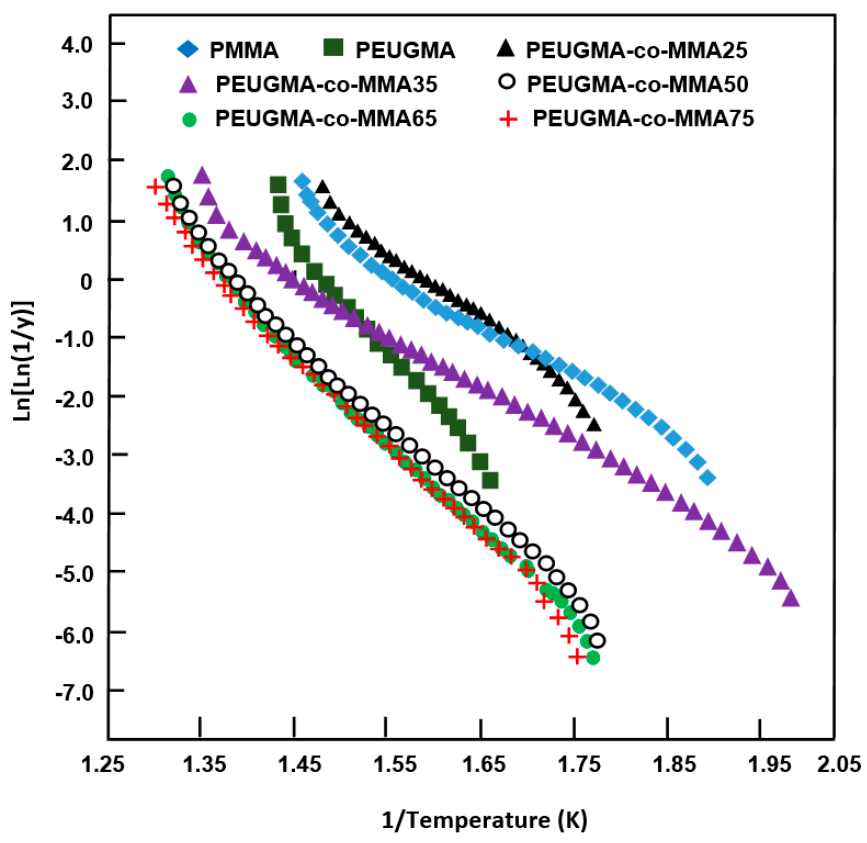
Figure 16. Variation of Ln[Ln(1 / Y)] vs. the inverse of temperature plotted for PMMA, PEUGMA and their corresponding copolymers.